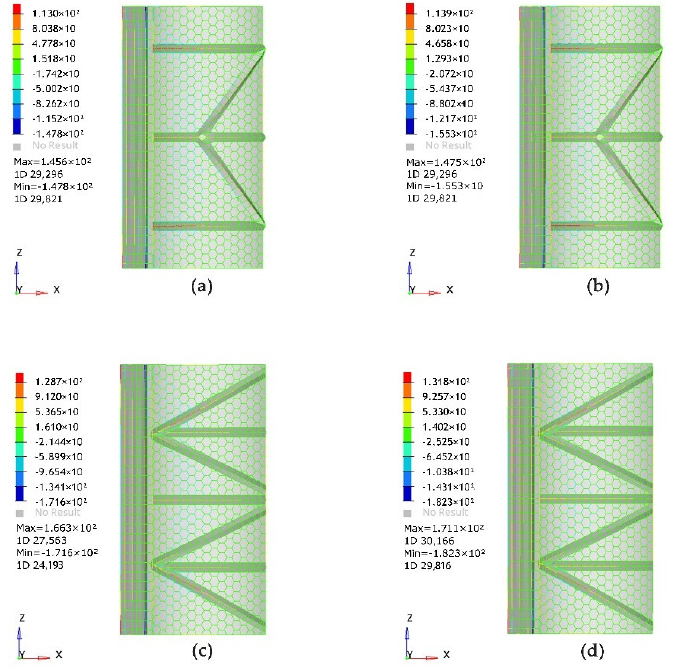
Figure 17. ( a ) Linear stress analysis of the carport I model under the load of 1.2 G k + 1.4 Q L + 1.4 × 0.85 Q W ; ( b ) Nonlinear stress analysis of the carport I model under the load of 1.2 G k + 1.4 Q L + 1.4 × 0.85 Q W ; ( c ) Linear stress analysis of the carport II model under the load of 1.2 G k + 1.4 Q L + 1.4 × 0.85 Q W ; ( d ) Nonlinear stress analysis of the carport II model under the load of 1.2 G k + 1.4 Q L + 1.4 × 0.85 Q W under the carport II model nonlinear stress analysis.